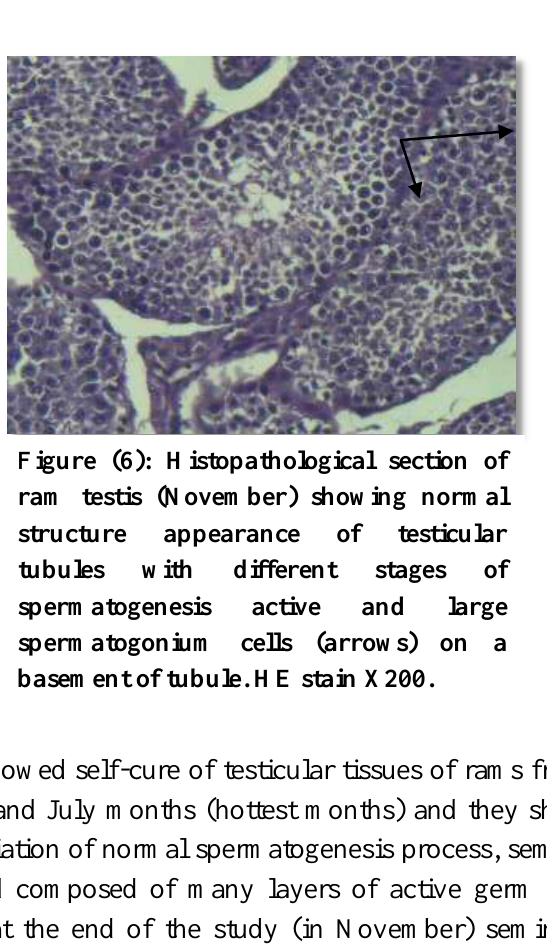
Figure (5): Histopathological section of ram testis (October) showing normal maturation of spermatogonium cells and testicular tubules with presence of numerous numbers of sperms (arrows) inside the lumen of tubule. HE stain X200